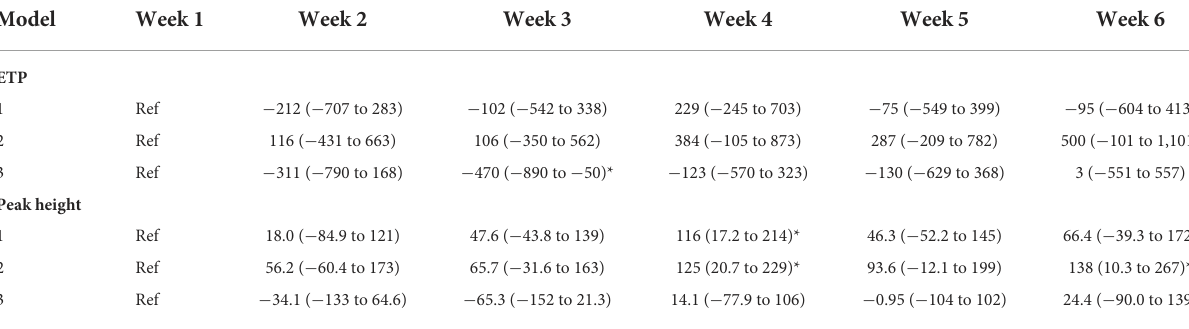
TABLE 4 Tissue factor-induced thrombin generation parameters, differences over